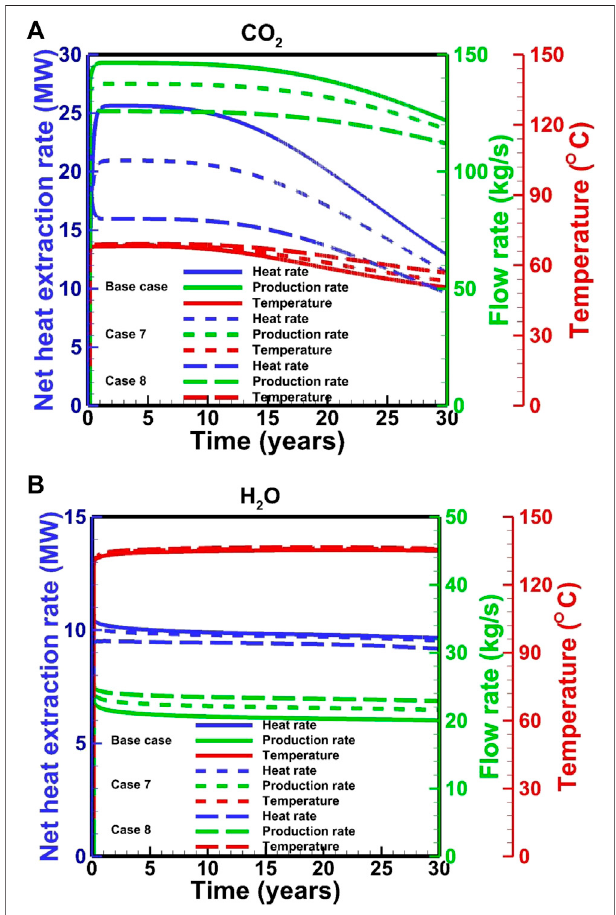
FIGURE 11 | Effect of injection temperature on the performance for (A) the CO 2 -based and (B) H 2 O-based EGS.